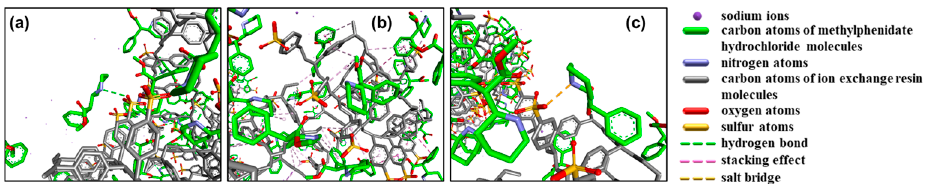
Figure 2. Interaction between MPH and the ion-exchange resin. (a) Hydrogen bonding interaction, (b) CH3- π and π - π stacking interaction, (c) salt bridge interaction.